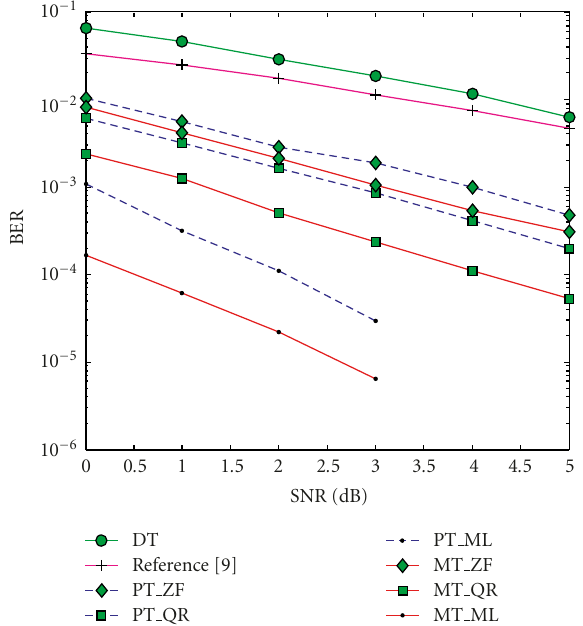
Figure 12: BER versus SNR (SNR in = SNR + 20dB, SNR rd = SNR + 15